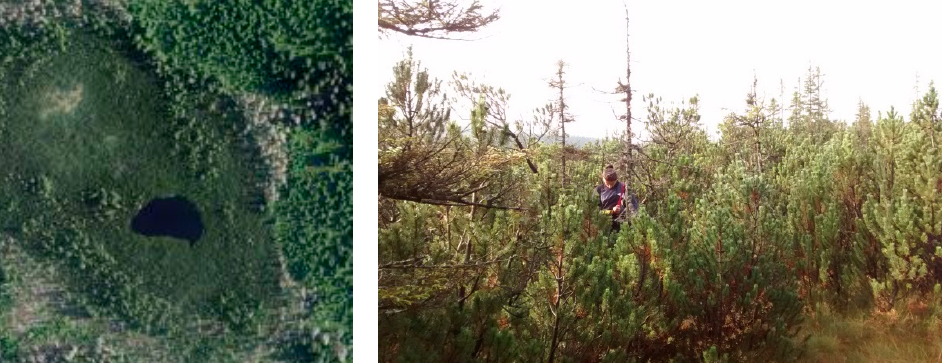
Figure A5. Aerial photo and photo of class B.